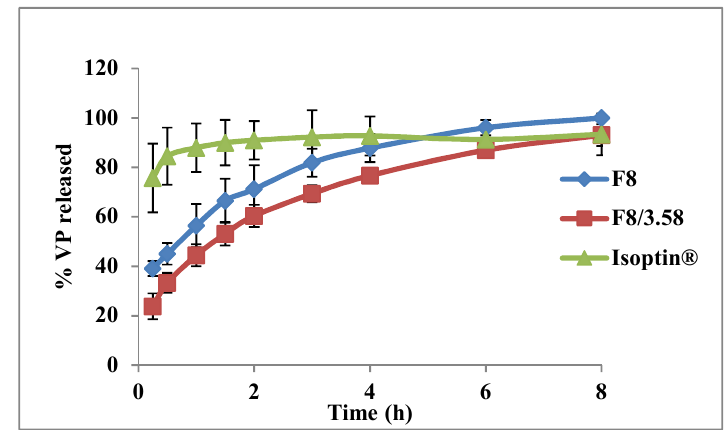
Figure 7. Release profiles of VP from the optimized systems compared to the marketed product (Isoptin ® ).